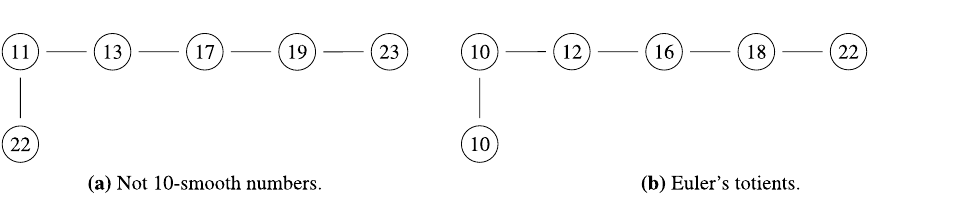
Figure 6. Enumeration of numbers that are not 10-smooth and their Euler’s totients in the interval [11,